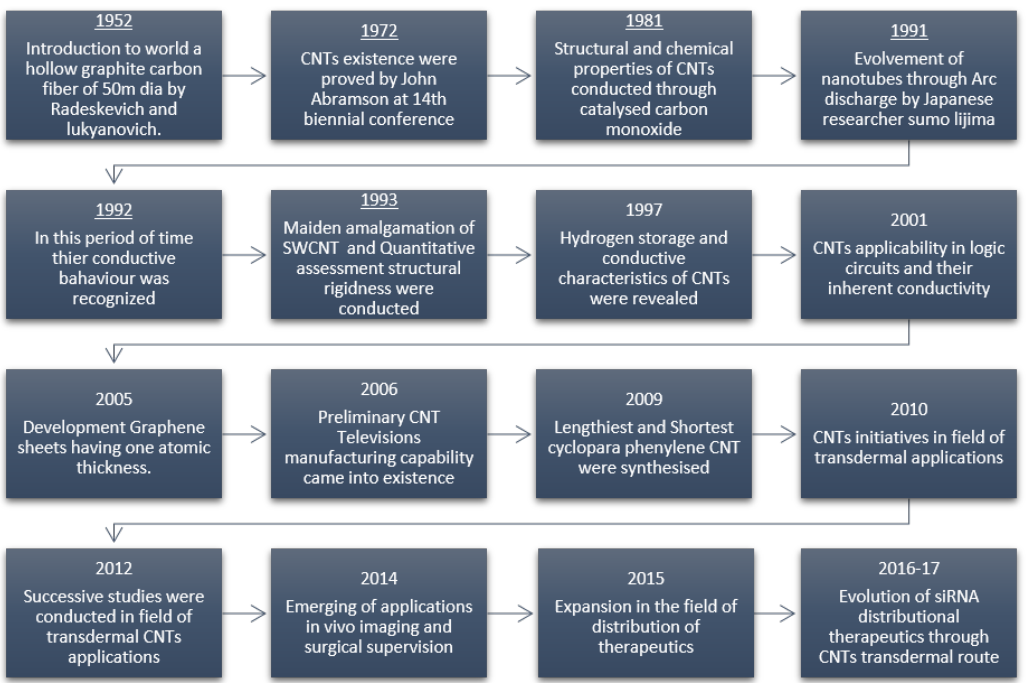
Figure 2. Evolution of CNTs at various stages and their major developments in several applications with respect to period of time.